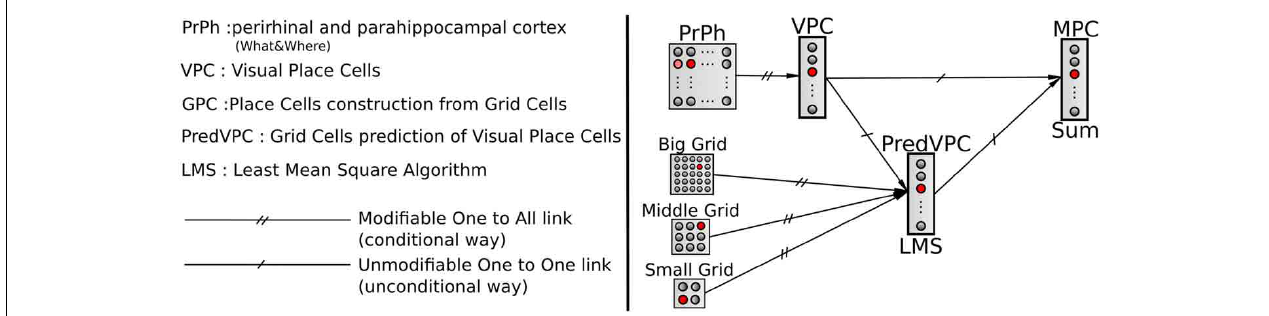
FIGURE 3 | A conditional association to merge visual and grid information. Associations between visual place cells (VPCs) as unconditional stimulus and place cells predicted by grid cells (PredVPCs) taken as conditional stimuli.